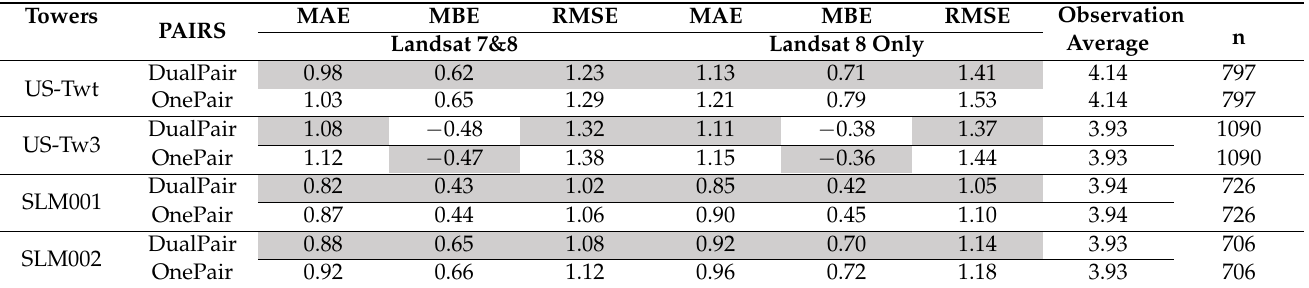
Table 1. Statistical metrics of evaluation of STARFM fused daily ET. Observation Average is the average value from flux tower observed closed ET (mm/day); n is the total number of observations; MAE is mean absolute error (mm/day); MBE is mean bias error (mm/day); RMSE is root mean square error (mm/day). The grey color highlights the method of best performance, comparing dual-pair and